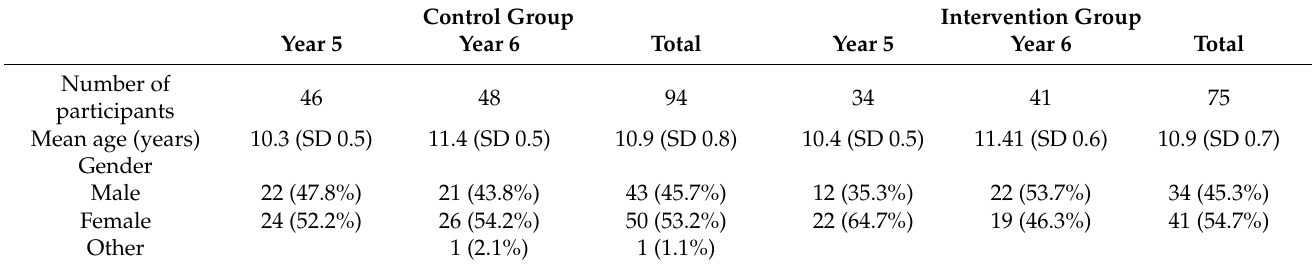
Table 1. Descriptive statistics of matched (T1-T2)